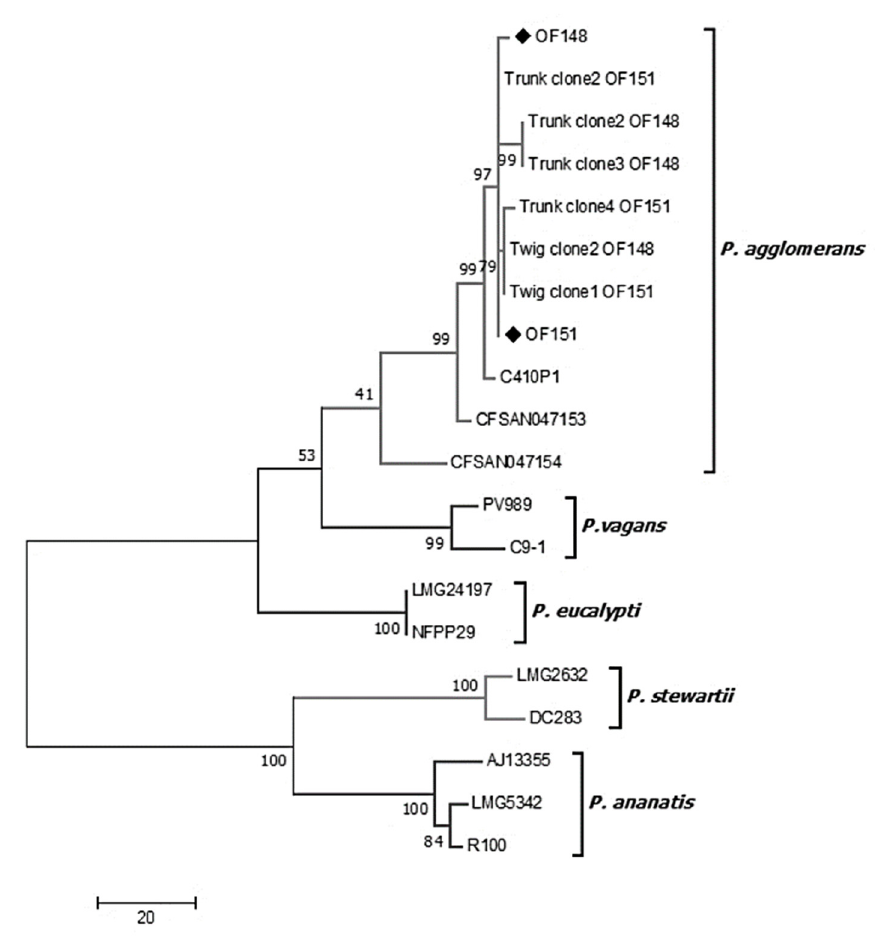
Figure 5. Phylogenetic distribution by the method of maximum parsimony, obtained from the mul- tilocus sequence analysis of the atpD , infB , rpoB , and 16S rRNA genes (2760 bp) of P. agglomerans isolated from pistachio. The values indicated on the nodes represent a bootstrap of 500 repetitions. OF148 and OF151: original isolates, ( ♦ ) bacterial isolates from infected plants in the orchard. Se- quences from the genus Pantoea are listed below, along with their geographic origins and GenBank